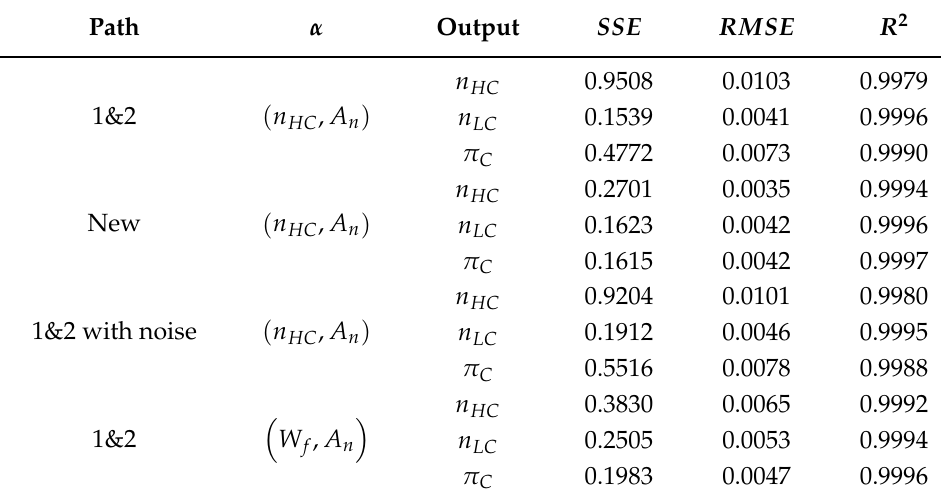
Table 3. Accuracy results of EME model under different dynamic paths.